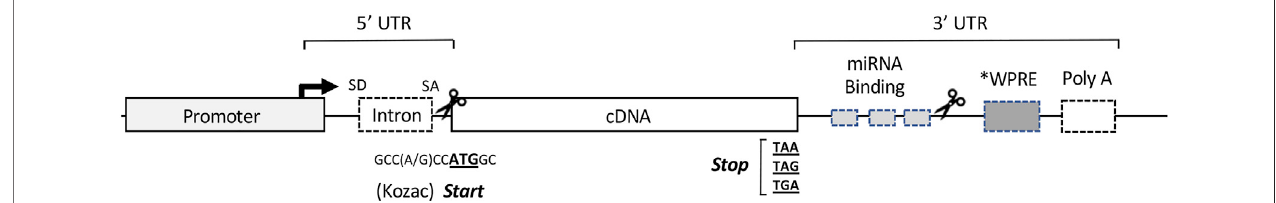
FIGURE2| Organizationofthecis-actingsequenceelementsinatypicalexpressioncassettefortherapeuticgenetransfer.Formostvectorsystems,bothviraland non-viral, the expression cassette is designed to provide high-level synthesis of the transgene product independent of the regulatory constraints of the endogenous gene. The speci fi c sequences of the elements in a particular cassette are often assembled from a variety of sources, both eukaryotic and viral (Keravala and Gasmi, 2021).ThePromoterlocatedatthe5 ′ endofthecassette,drivestranscriptionofthetherapeutictransgene(oftenthecDNAofasecretedprotein).Thetranscription start site and direction of RNA synthesis are indicated by the arrow . The DNA sequences downstream from the promoter serve as the template for RNA synthesis, and the regions indicated represent the cis- acting RNAsequences in the 5 ′ and 3 ′ untranslated regions (UTRs) to enhance or regulate translation ofthe RNAtranscript. The Intron: as a cDNA represents the protein coding sequence of a mature mRNA, an intronic sequence with fl anking splice donor (SD) and acceptor (SA) sites is used to direct splicing of the primary transcript to enhance nuclear export and translation. The cDNA: the locations and template sequences of the translation start and stop codons are shown in bold. A consensus Kozac sequence fl anks the ATG start codon, and during codon optimization is engineered into the sequence of the cDNA to enhance translation initiation and prevent cryptic starts at internal ATG (AUG) codons. miRNA Binding Sites: in the 3 ′ UTR, recognition sites for the binding regions of select miRNAs can be inserted to fi ne-tune or conditionally modulate mRNA translation in speci fi c applications. WPRE: a woodchuck hepatitis virus post-transcriptional regulatory element or similar PRE can be inserted to enhance nuclear export and translation. Poly A: the polyadenylation signal at the 3 ′ end of the transcript serves as a cleavage site for the addition of the polyadenosinetract, which promotes nuclear export, mRNA stability and translation. Scissors: designate cloning sites for removal or insertionofcDNA(s)ofinterest.Regionsinternaltothecloningsitesrepresentsequenceelementsspeci fi ctoindividualapplications,whilethoseoutsidearemoregeneric and stably reside in the expression cassette of the